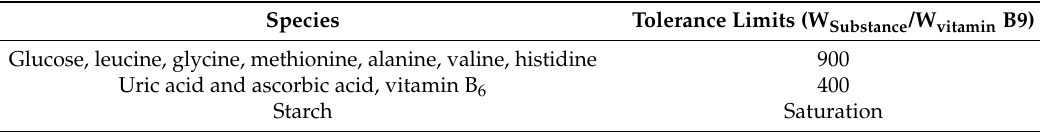
Table 2. Interference study for the determination of 10.0 µ M vitamin B 9 .